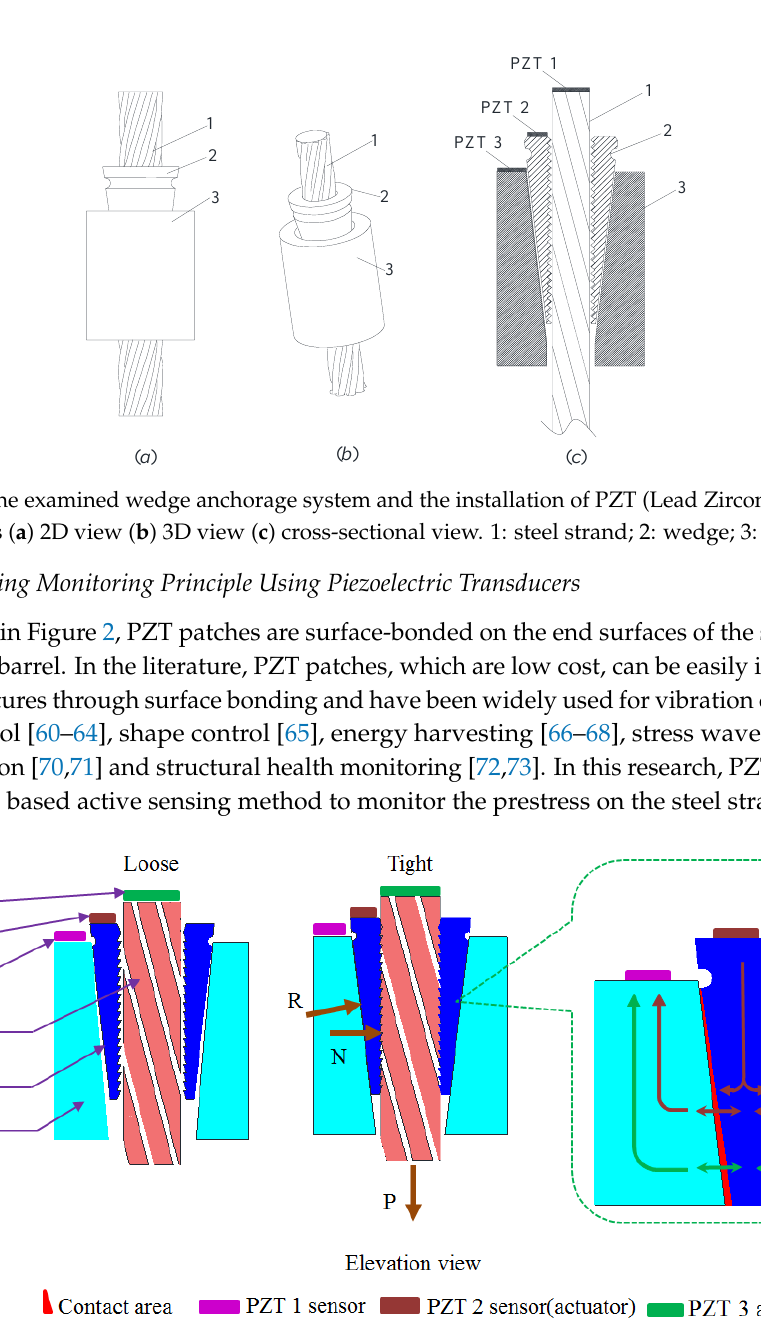
Figure 2. Microscopic view and energy transmission across contact interfaces for the wedge anchorage system.